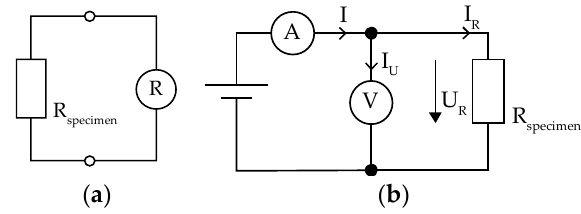
Figure 3. Representation of defects due to insufficient flowability using the example of M3D.